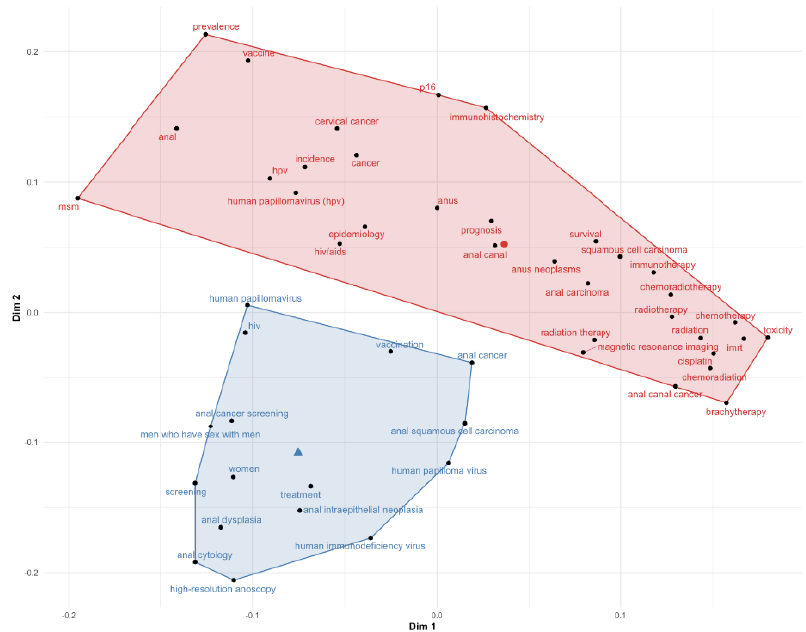
Figure 3. Factorial analysis of analyzed keywords. The distance between keywords indicates shared substance. The colors distinguish different